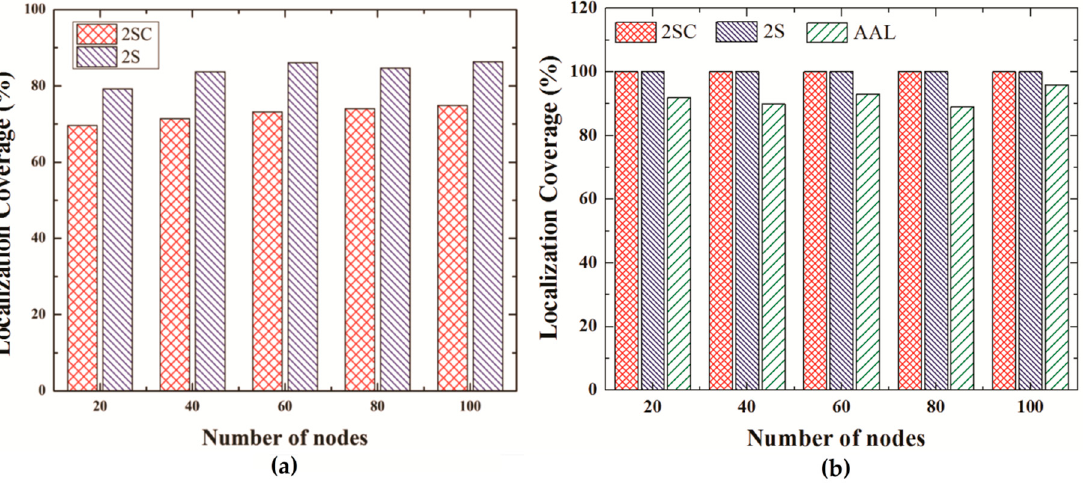
Figure 10. ( a ) Localization Coverage for No. of iterations = 2. ( b ) Localization Coverage for No. of iterations = 3(2S, 2SC), AUV Aided Localization.